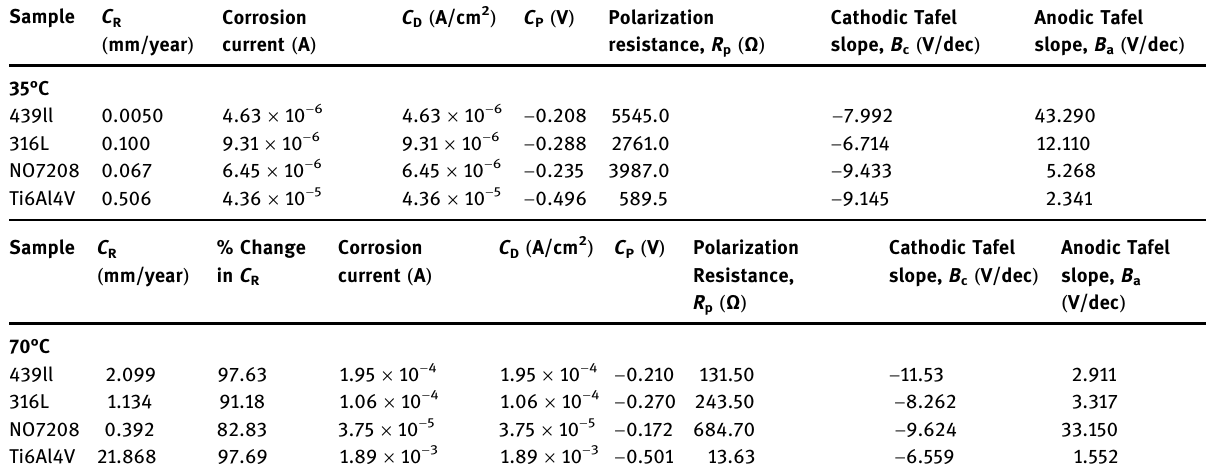
Table 2: Corrosion polarization data for 439ll, 316L, NO7208, and Ti6Al4V alloys in 4 M H 2 SO 4 + 5% NaCl solution at 35 and 70°C